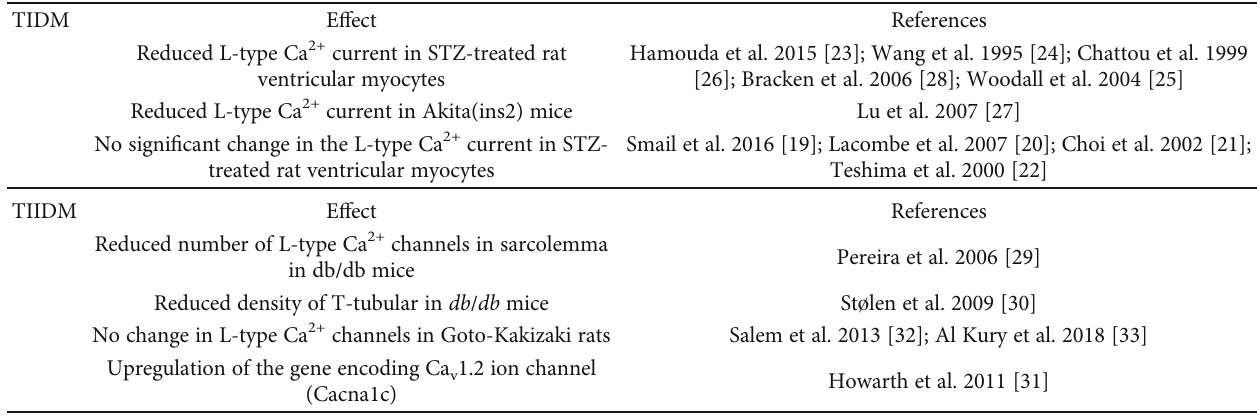
Table 1: E ff ect of DM on the L-type Ca 2+